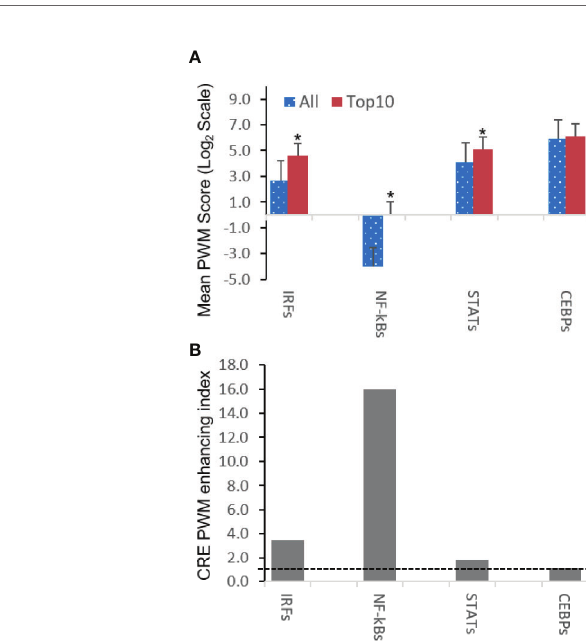
FIGURE 5 | Intergenic regions immediately ahead of highly expressed FV3 genes containing cis -regulatory elements (CREs) exhibit higher likelihood of binding vertebrate IRFs, NF- k B2-like, and STAT1-like transcription factors. (A) Shown are overall averages of PWM scores per compared CREs in all FV3 intergenic regions (All) and those are immediately upstream of top-ten highly expressed FV3 coding genes (Top10) in each temporal class of immediate early (IE), delay early (DE), or late (L) genes as revealed by transcriptomic analyses. Mean PWM scores were calculated as in previous fi gures. * p < 0.001 and n = 10, compared to the All group. (B) The CRE PWM enhancing index was adopted to compare fold changes of mean PWM scores between the Top10 and All groups after normalization with the PWM evolution of TATA-box between the two groups as baseline (indicated by the dash line). Abbreviations of TFs are as in Figure 3